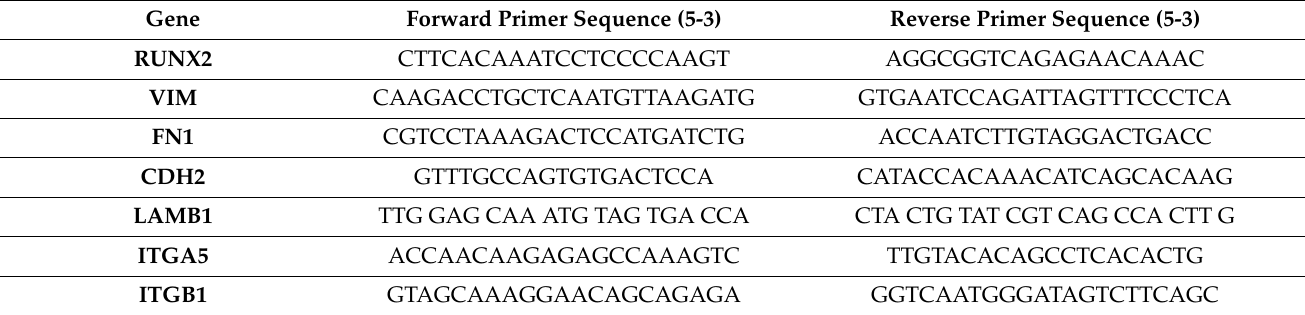
Table 1. Primer sequences used for real-time PCR